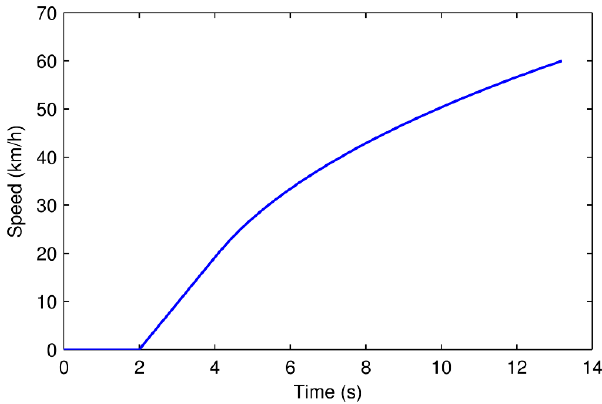
Figure 10. Speed profile during the maximum acceleration 0–60 km/h.